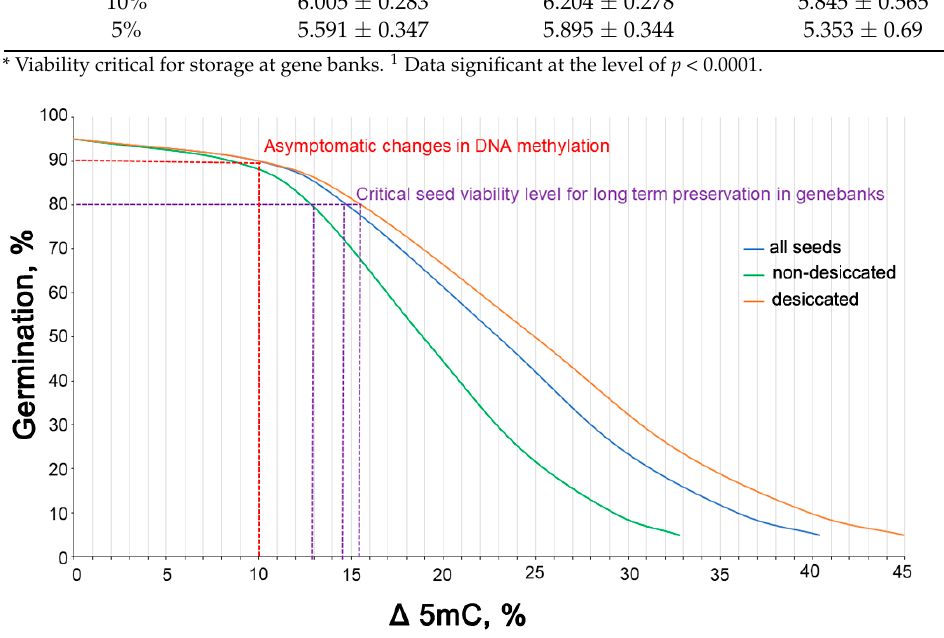
Figure 7. The relationship between germination capacity (%) of Populus nigra L. seeds and relative percentage of decline ( ∆ %) at 5mC level for: all seeds (dark blue, n = 120, AIC = 73.605); non-desiccated seeds at the MC range of 12.5–14.5% (green, N = 60, AIC = 41.184); and desiccated seeds at the MC range of 7.6–7.8% (orange, N = 60, AIC = 34.459). As a reference data, the percentage of 5mC at a germination level of 95% calculated with the dose.p function in R was used. All GLM model coefficient values are provided in Table S1.